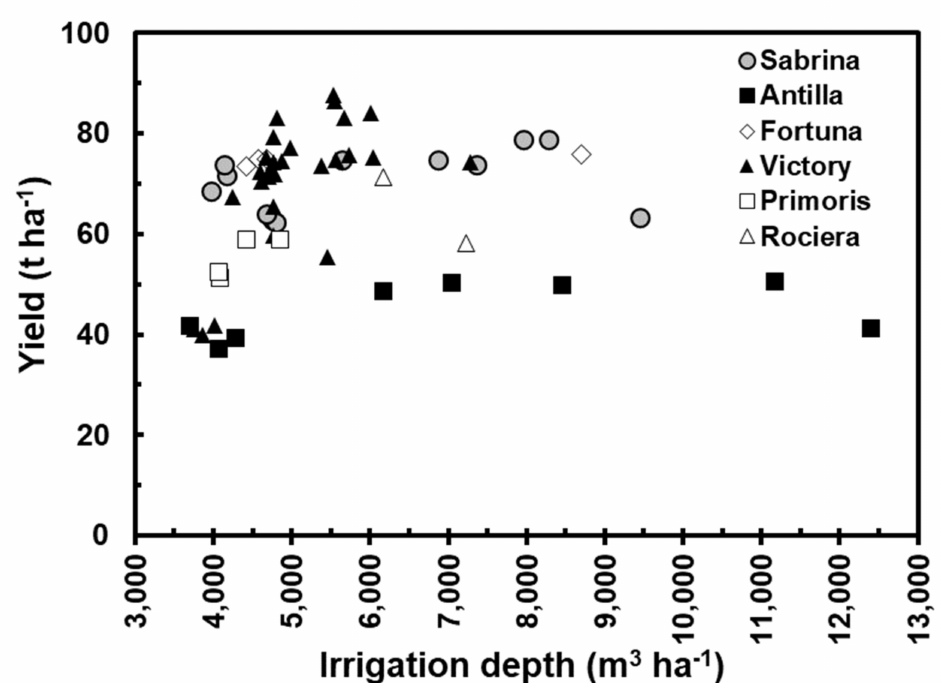
Figure 3. Applied irrigation depths and yields in 57 strawberry plots between 2012 and 2017 for six strawberry cultivars (Sabrina, Antilla, Fortuna, Victory, Primoris and Rociera) in the province of